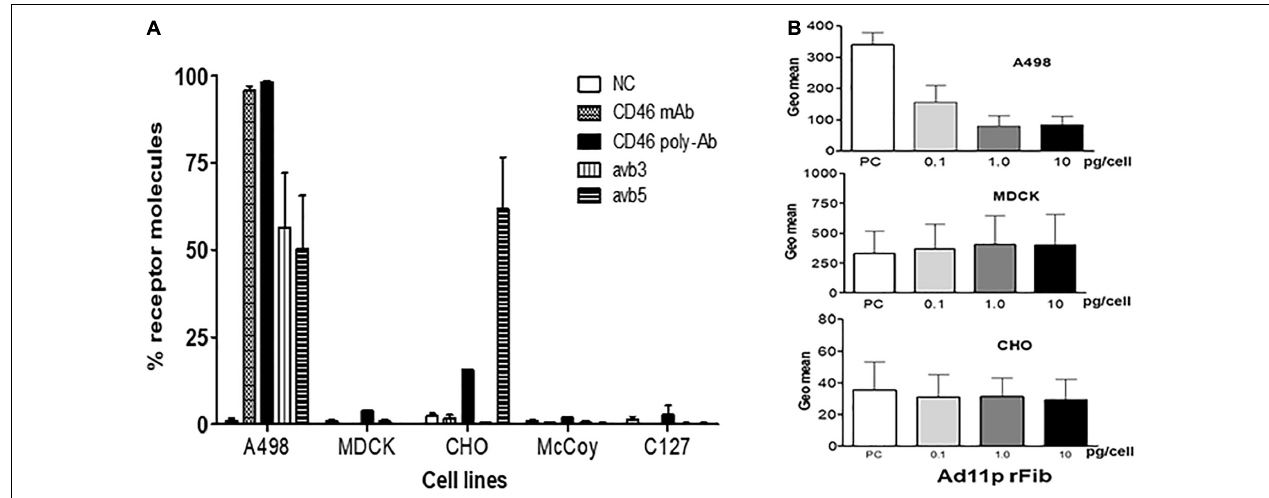
FIGURE 1 | Receptor molecules on human and animal cells for infection with Ad11p virus detected using FACS analysis on human and animal cells. (A) Expression of the cell surface markers, CD46, and integrins ανβ 3 and ανβ 5, determined in the studied cell lines. The cells were incubated with antibodies against monoclonal or polyclonal CD46, integrin ανβ 3, and integrin ανβ 5. The expression of the relevant cell surface molecules on the animal cells studied was determined by flow cytometry analysis. The experiments were performed in duplicate, and at least three independent experiments were performed. (B) The Ad11p-fibre receptor on the MDCK and CHO cells was further inhibited by the addition of the Ad11prfib protein; A498 cells served as the positive control. A dose-dependent reduction of GFP expression in response to Ad11prfib protein was observed in A498 cells but not in MDCK and CHO